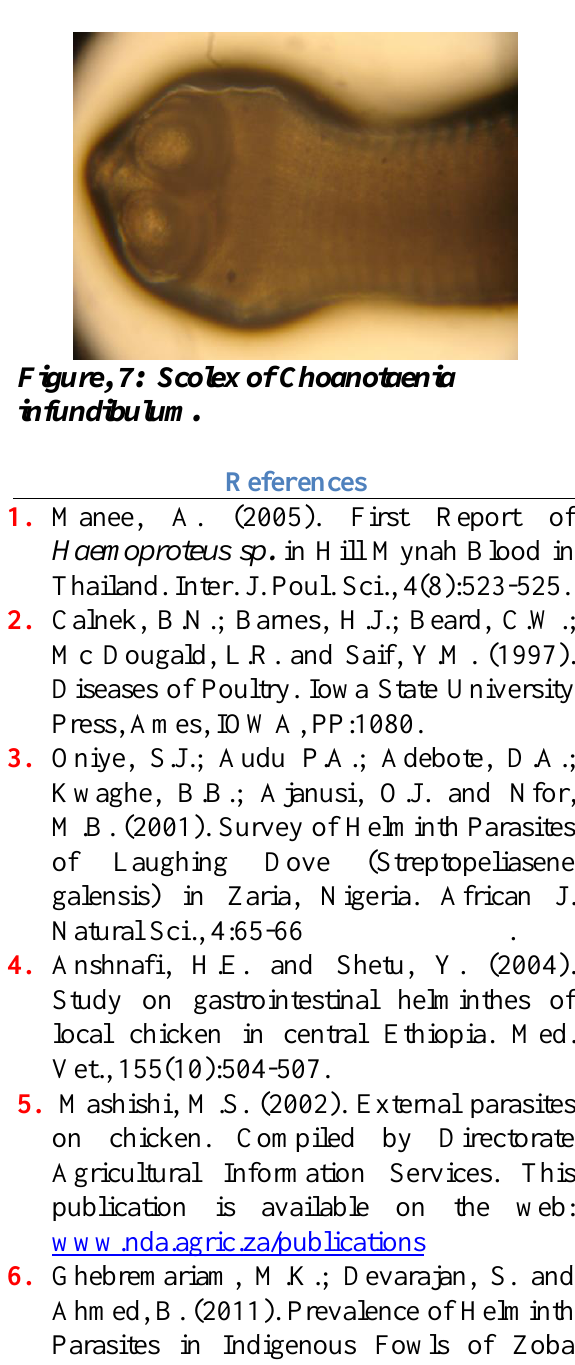
Figure, 5: Raillietina spp. Figure, 6: Scolex of Choanotaenia infundibulum.